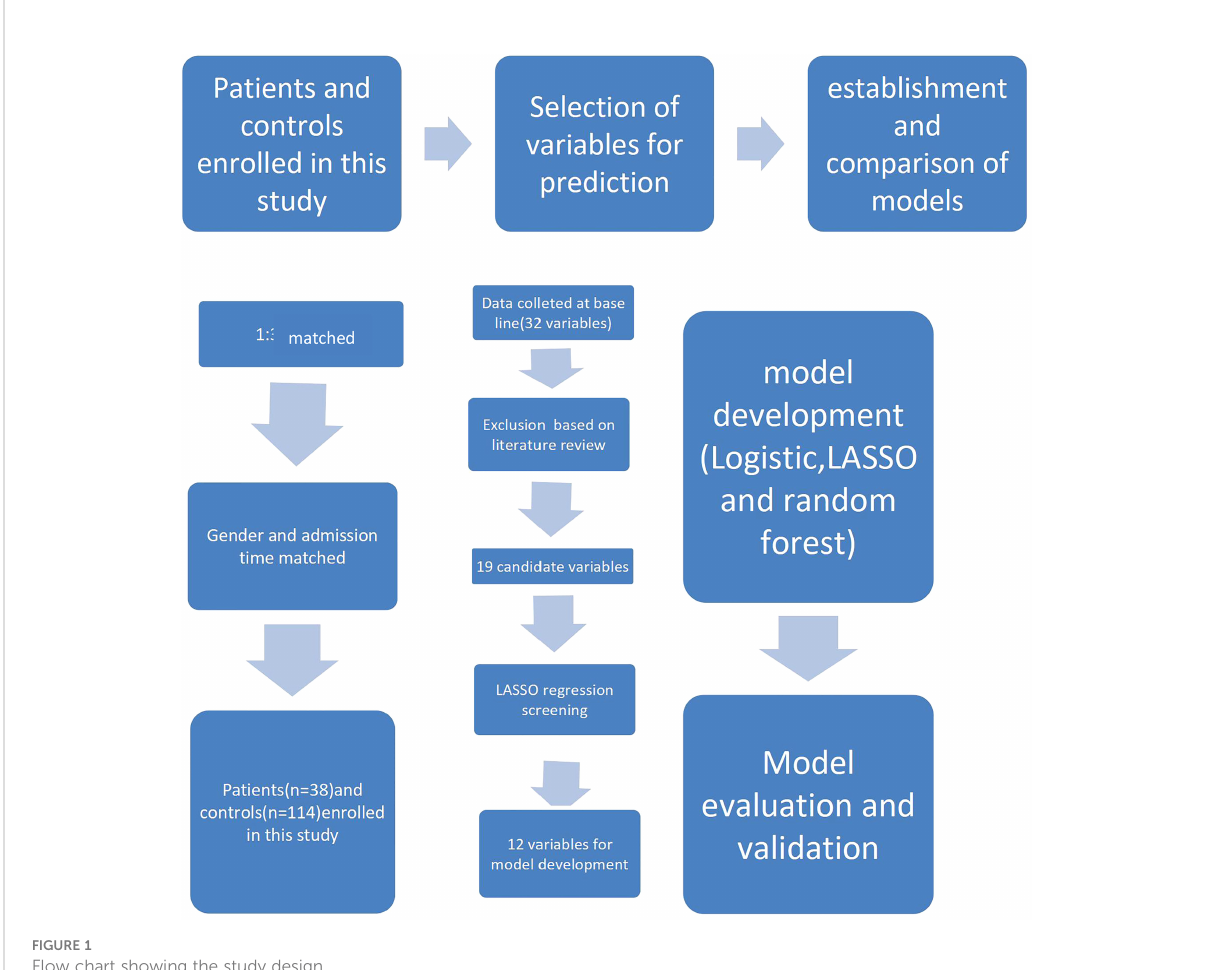
FIGURE 1 Flow chart showing the study